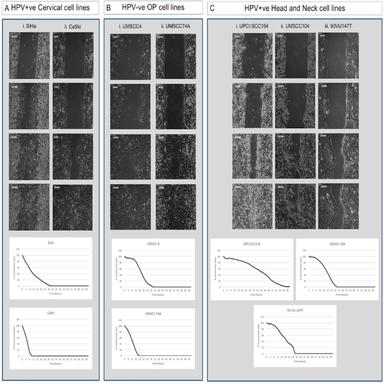
Representative images from differing time points (due to different migration speeds) demonstrating different methods of cell migration. Graphs: Time to gap closure. Each point on curve represents average of 6 points across 3 wells per cell line (2 in each well).